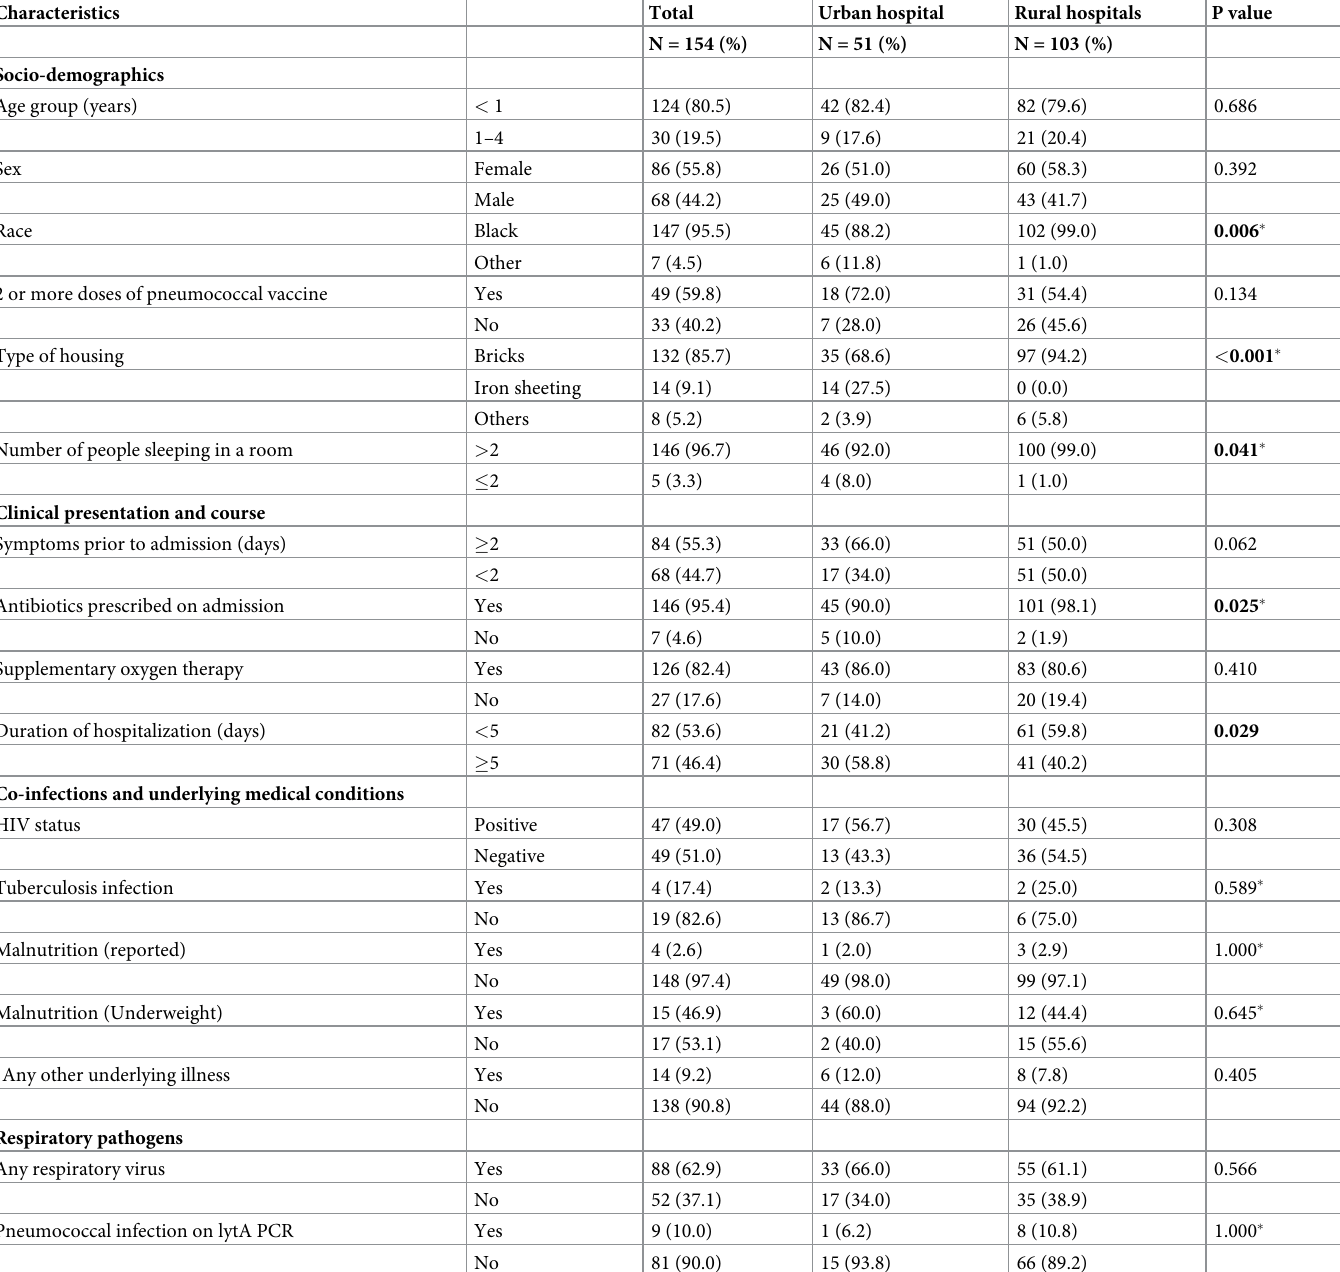
Table 5. Factors associated with hospital site (rural vs. urban) among children aged < 5 years hospitalized with SARI who died in hospital, South Africa, 2009– 2013.